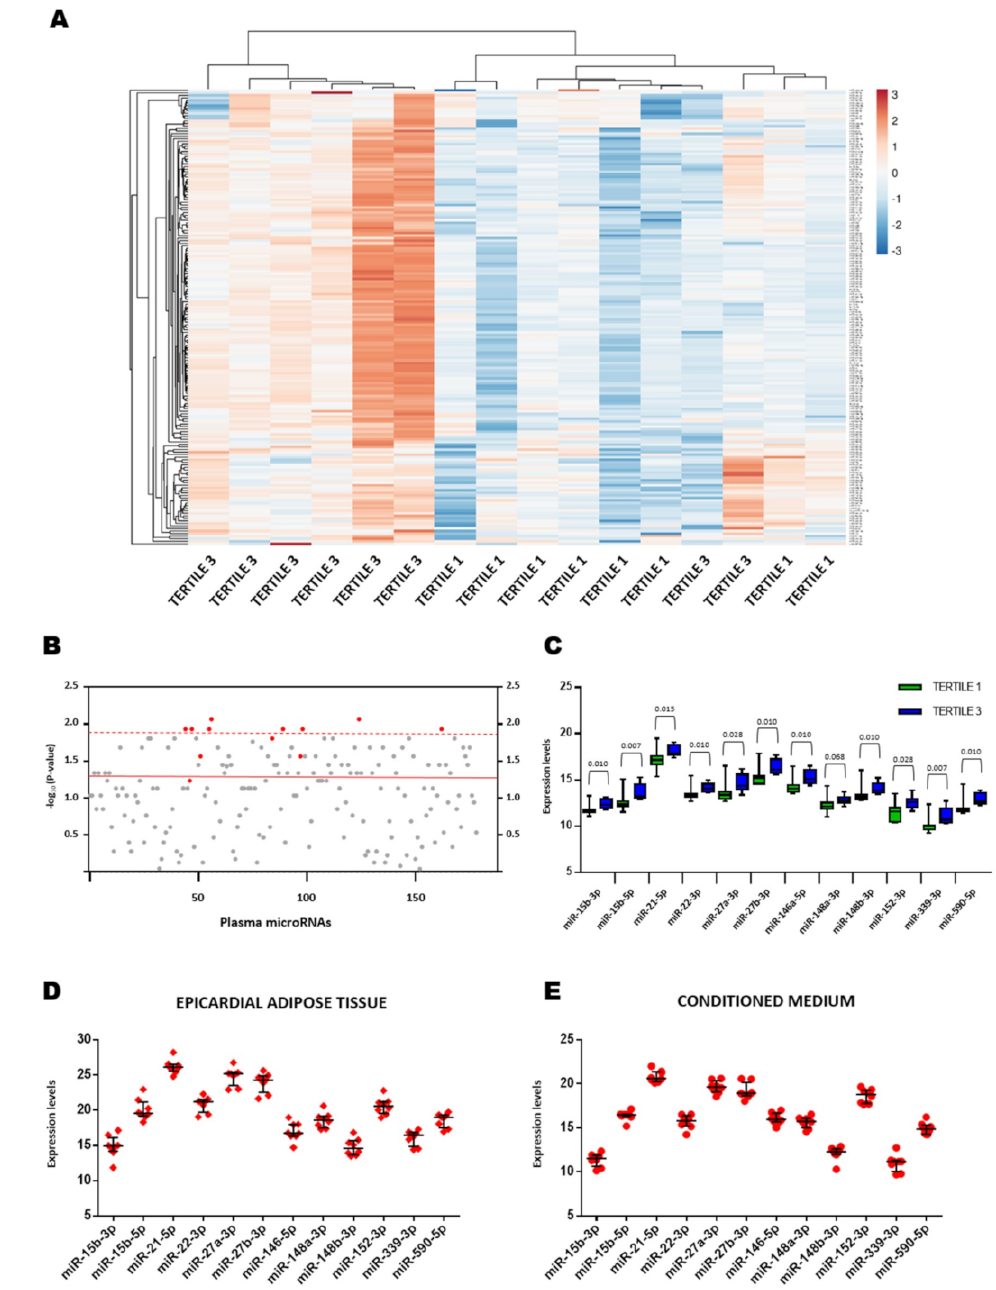
Figure 1. Plasma microRNA (miRNA) profiling. ( A ) Unsupervised hierarchical clustering. The heat map diagram shows the result of a two-way hierarchical clustering of patients and miRNAs. Each column represents a patient (Tertile 1 of epicardial fat volume vs. Tertile 3 of epicardial fat volume). Each row represents a miRNA. The patient clustering tree is shown on top. The miRNA clustering tree is shown on the left. The color scale illustrates the relative expression level of miRNAs. The expression intensity of each miRNA in each sample varies from red to blue, which indicates relatively high or low expression, respectively. ( B ) p value for the comparison between study groups. Each point represents a miRNA. Red dots represent the selected candidates. ( C ) Plasma expression levels of miRNAs in study groups. ( D ) Expression levels of miRNAs in epicardial adipose tissue explants. Each point represents a sample. ( E ) Expression levels of miRNAs in conditioned media exposed to epicardial adipose tissue explants. Each point represents a sample. Relative quantification was performed using cel-miR-39-3p as the external standard for extracellular miRNAs and SNORD48 as the internal standard for tissue miRNAs. MicroRNA levels were log2-transformed. MicroRNA expression levels are expressed as arbitrary units. Di ff erences between groups were analyzed using the Mann–Whitney U test. p values describe the significance level of di ff erences for each